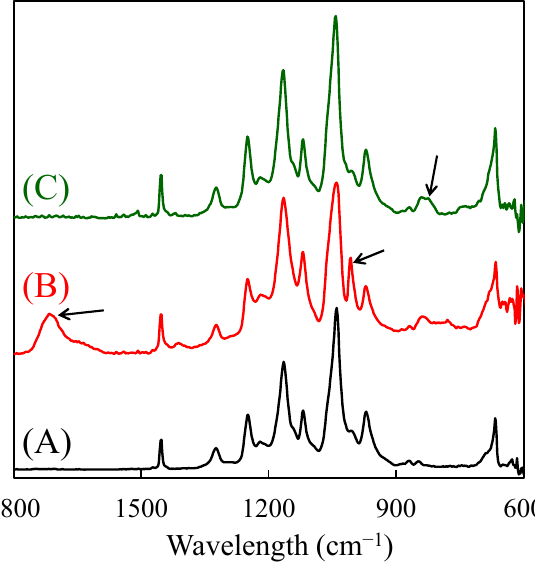
Figure 5. FT-IR spectra of the base ETFE film (A), SSS + acrylic acid (AA)-grafted side (B), and CMS-grafted side (C) of the grafted film prepared in Run 4 in Table 4.